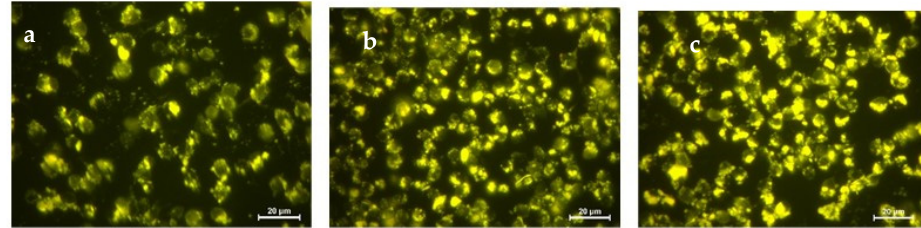
Figure 7. Fluorescence imaging of RAW 264.7 incubated with: ( a ) S1 (100 µg/mL), ( b ) S1 (100 µg/mL) + Spd (100 µg/mL), ( c ) S1 (100 µg/mL) + Spd (200 µg/mL).